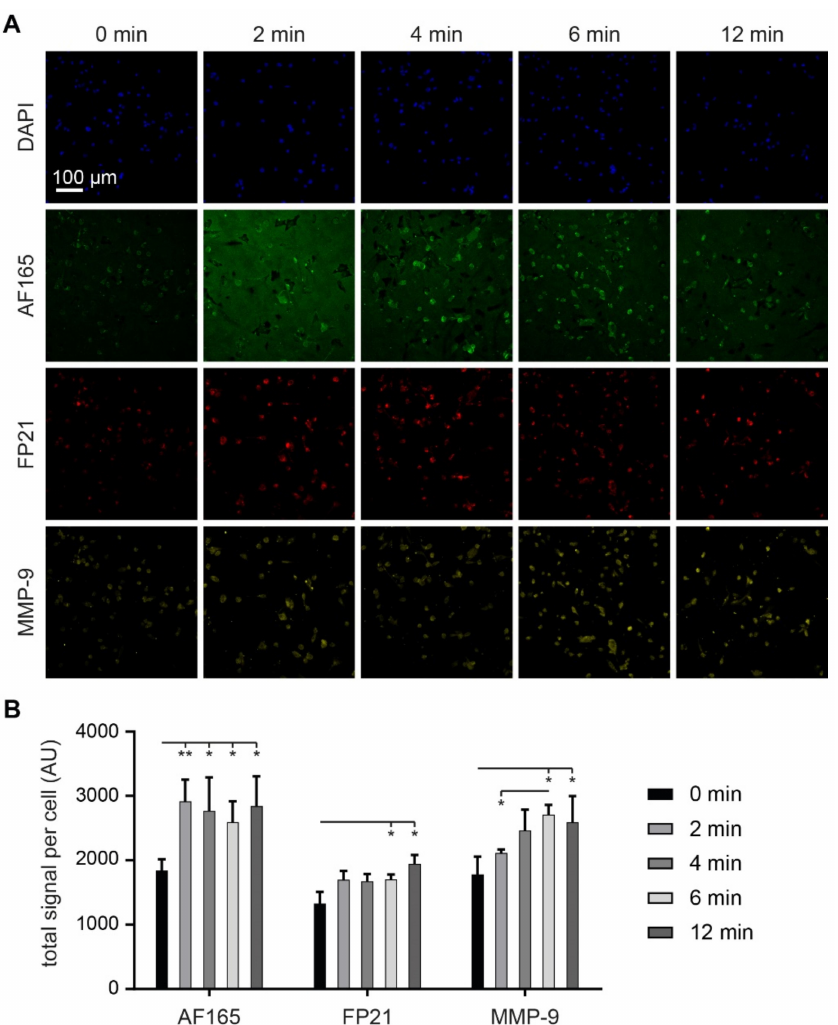
Figure 7. Incubation with MMP-9 protein enhances anti-BSP immunofluorescence. 1,200,000 MDA- MB-231 cells were seeded in Petri dishes containing glass cover slips. After 4 d, cultures were treated with 400 ng/mL MMP-9 in FCS-free media for exposure times as indicated, or with fresh media as 0 min control. Then, samples were fixed and stained for DAPI and human BSP (AF165 and FP21) as well as MMP-9. ( A ) Representative confocal images in sum projections. ( B ) Graphs showing quantitative analysis of fluorescence intensities per cell. Mean + SD ( n = 3; * p < 0.05, ** p <